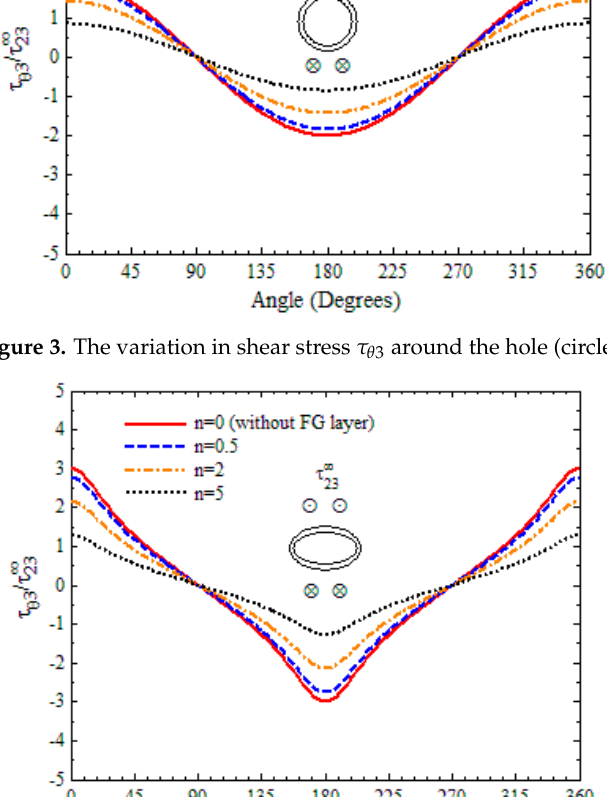
Figure 4. The variation in shear stress τ θ 3 around the hole